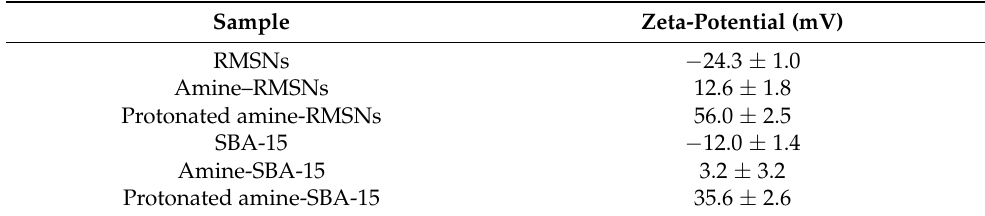
Table 1. Zeta-potential of different RMSNs and SBA-15